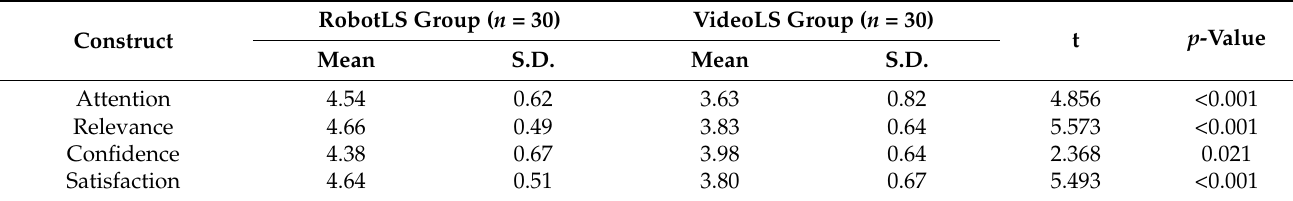
Table 6. Independent samples t-test on learning motivation.